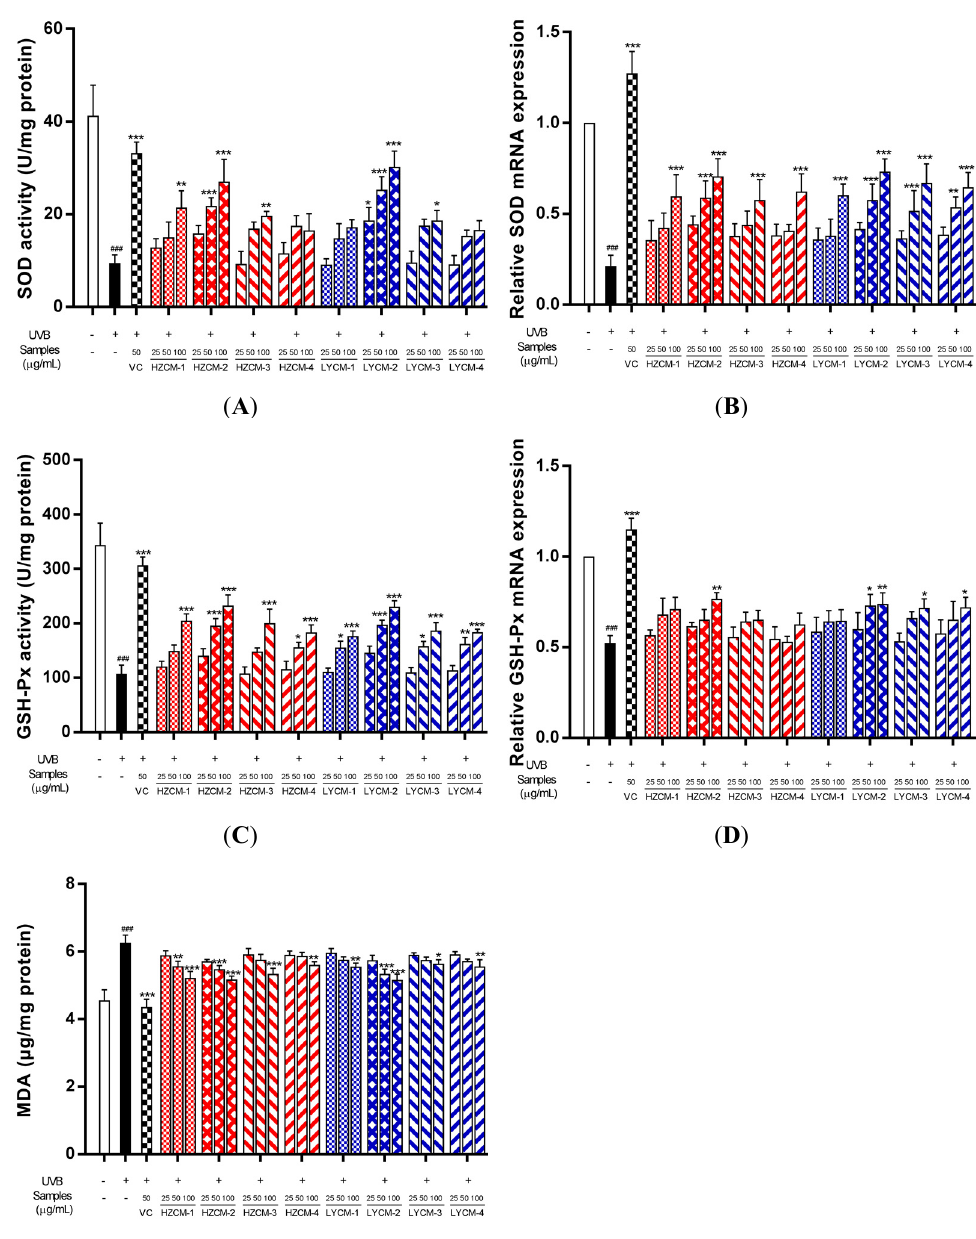
Figure 3. Ex vivo antioxidant effects of Cortex Moutan extracts. Effects of Cortex Moutan (CM) extracts on the activity of SOD ( A ), the relative expression of SOD mRNA ( B ), the activity of GSH-Px ( C ), the relative expression of GSH-Px mRNA ( D ), and the production of MDA ( E ). Vitamin C: VC; HZCM-1, HZCM-2, HZCM-3, and HZCM-4: Cortex Moutan collected in Heze in March, June, September, and December, respectively. LYCM-1, LYCM-2, LYCM-3, and LYCM-4: Cortex Moutan collected in Luoyang in March, June, September, and December, respectively. The content of malondialdehyde (MDA) and the activity of superoxide dismutase (SOD) and glutathione peroxidase (GSH-Px) were measured by colorimetric assay kits. SOD and GSH-Px mRNA expressions were examined by RT-PCR. The concentration of VC was 50 μ g/mL, and three concentrations of eight CM extracts were 25, 50, and 100 μ g/mL. Data are expressed as mean ± SD ( n = 3). * p < 0.05, ** p < 0.01 and *** p < 0.001 versus the model group with UVB irradiation; ### p < 0.001 versus the control group without UVB irradiation.